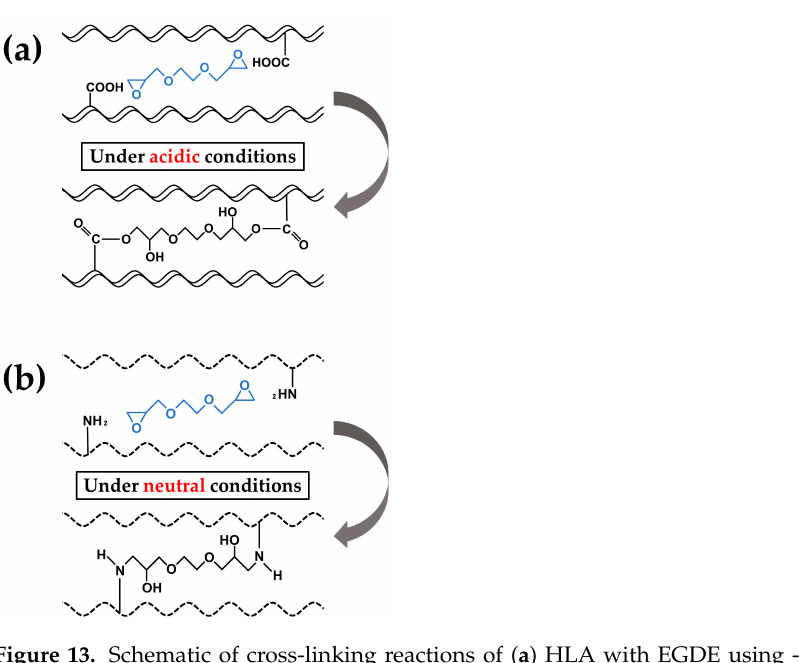
Figure 12. Two major cross-linking points of HLA, such as -COOH and -OH functional groups.